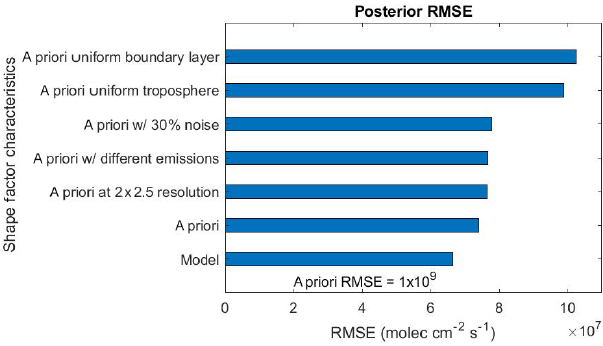
Figure 3. Global root mean square error (RMSE) values for 4D-Var estimates of NO x emissions for tests using various shape factors in AMF